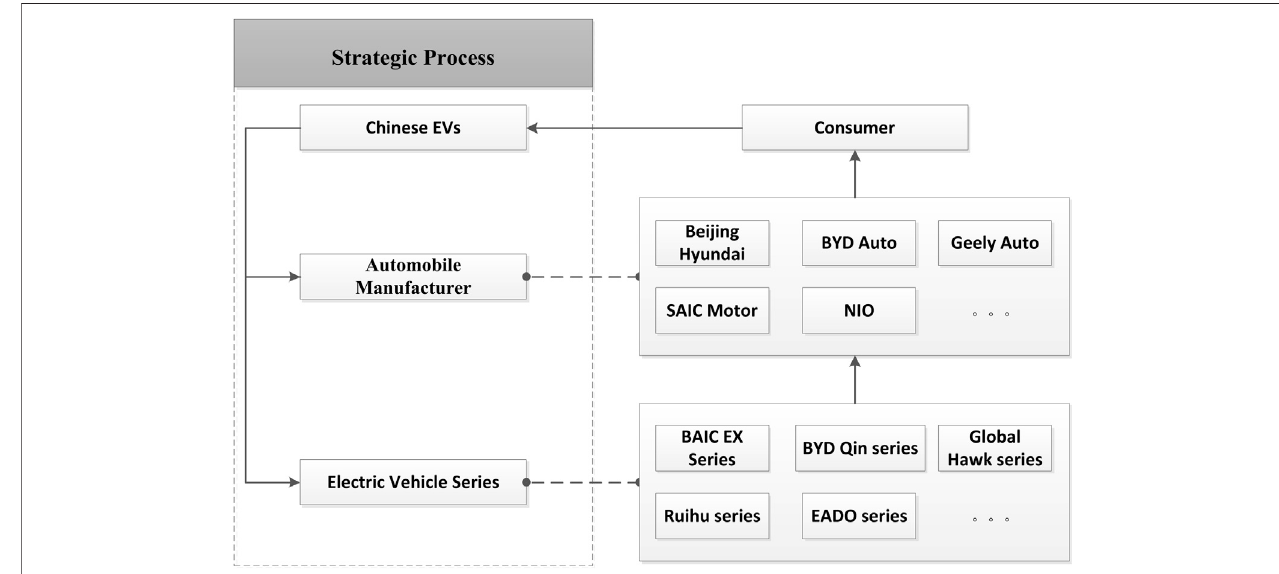
FIGURE 1 | Decision-making of consumers purchasing Chinese EVs.